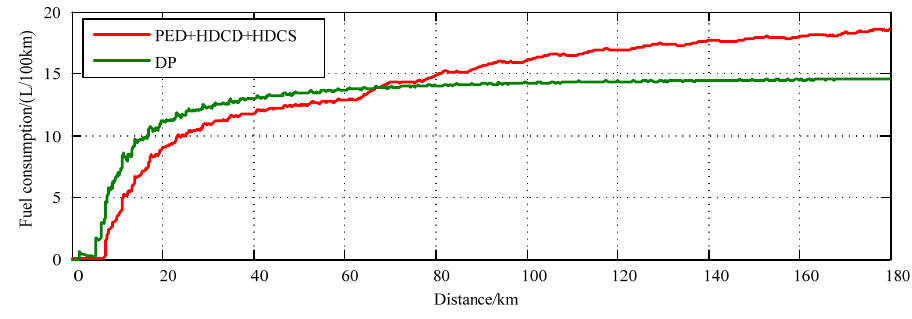
Figure 18. The relationship curve between fuel economy and trip distance under the two types of strategies.